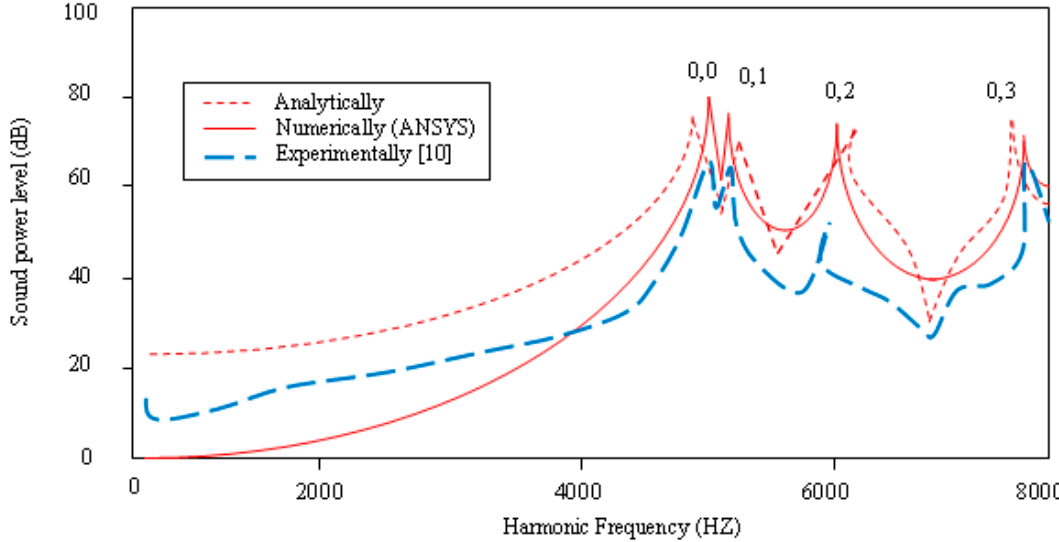
Figure 4. Comparison of sound power level analytically, numerically and experimentally for unloaded plate with uniform thickness for taper ratio T x = 0.00. Table 2. Validation and comparison of natural frequency parameter λ 2 of uniform clamped ‐ free